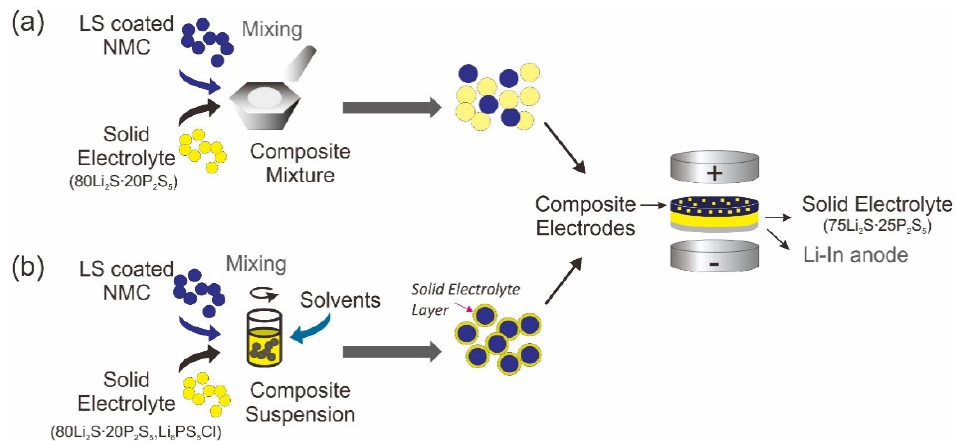
Figure 1. Processes used to prepare composite electrodes: ( a ) simple mixture; ( b ) solution process. Carbon additive VGCF is not illustrated to facilitate the explanation. Table 1. Ionic conductivity of the sulfide solid electrolytes (details in Section 3). Sulfide Solid Electrolyte